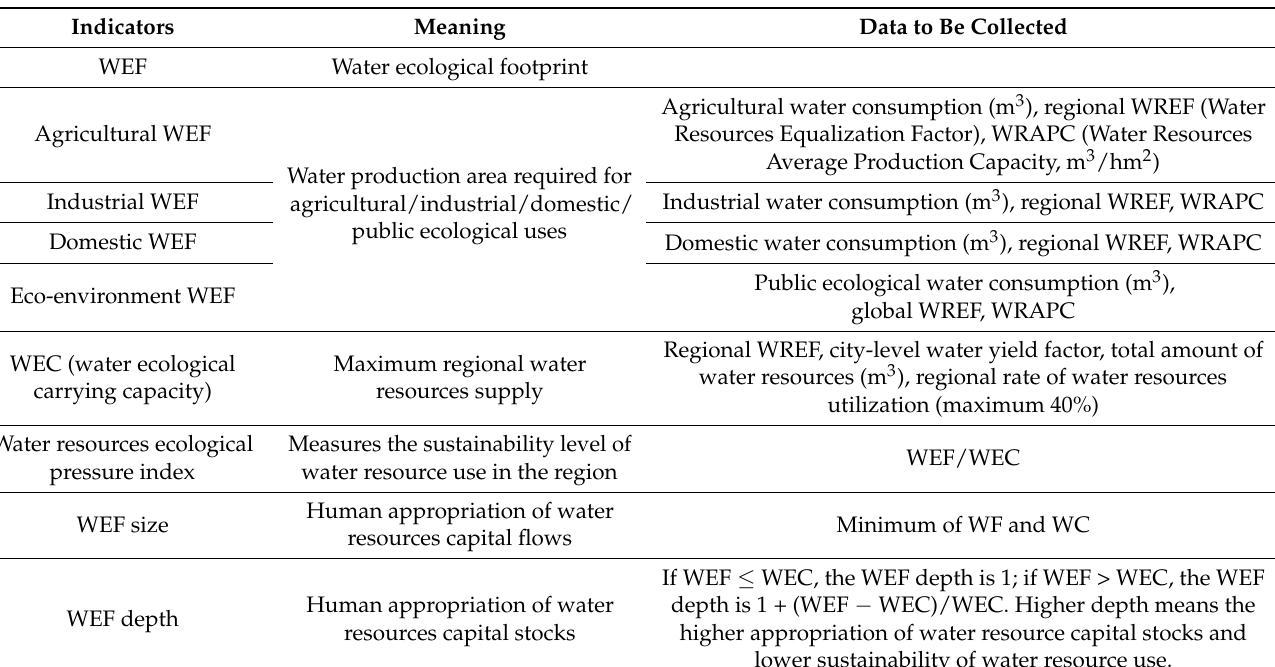
Table 2. Water ecological footprint (WEF) measurement